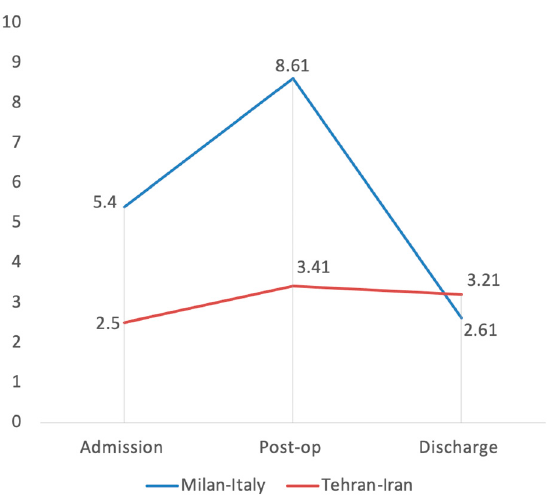
Figure 2. Trend of C-reactive protein (CRP) in COVID-19 Italian and Iranian groups.